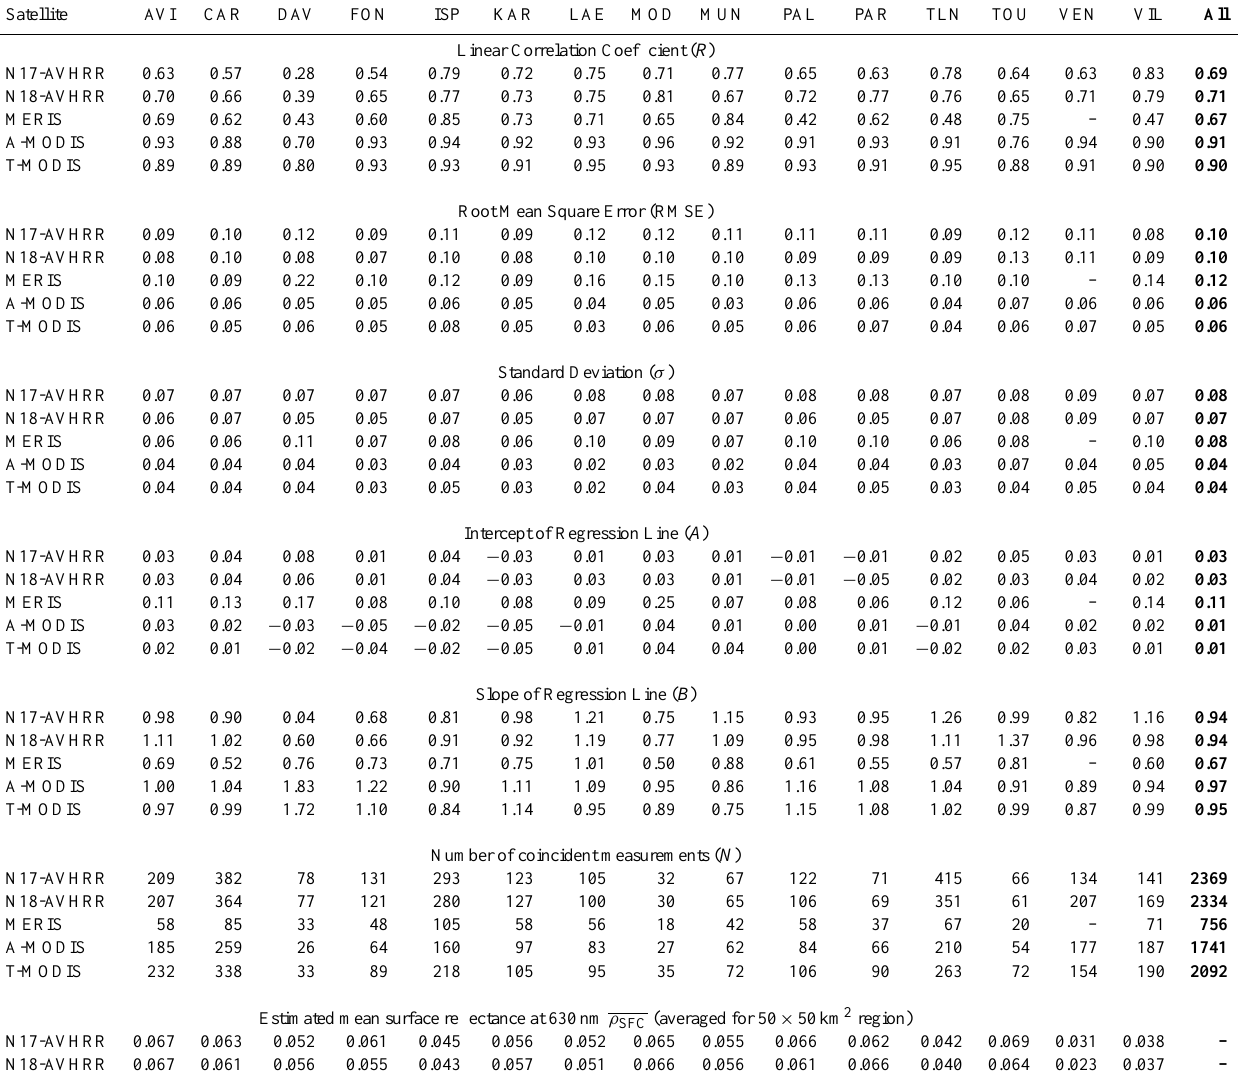
Table 3. Statistical results for the comparison between AERONET and the (AOD) retrievals from the various satellites. For NOAA-17 and NOAA-18 AVHRR the estimated mean surface reflectance ρ SFC is included as well. Abbreviations for the AERONET sites are explained in Table